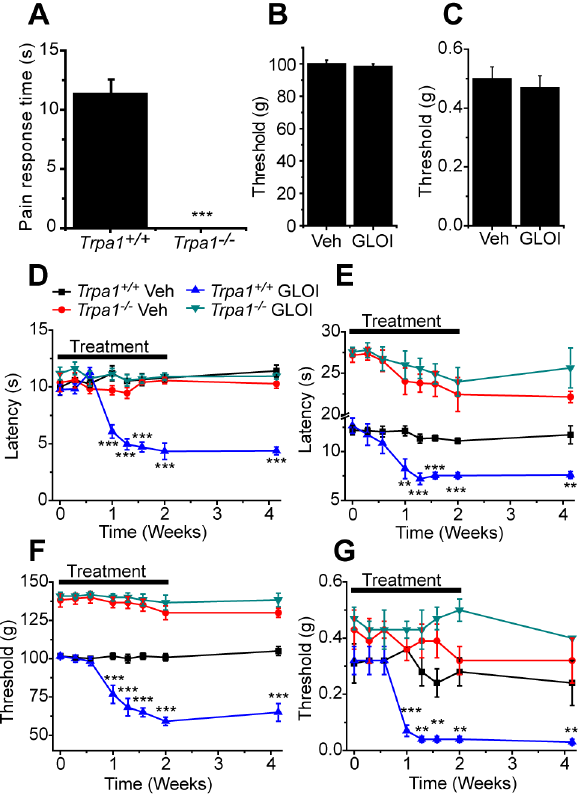
Figure 5. Methylglyoxal produce persistent sensory neuropa- thy. (A) Intraplantar injections of MG (250 nmoles in 25 m l) evokes nociceptive behaviors in wildtype mice but is without effect in Trpa1 2 / 2 mice (n=6). Injections of the GLO-1 inhibitor Sr-p-Bromobenzylglu- tathione cyclopentyl diester (GLOI, 50 mg/kg, 1h before test) did not acutely affect the withdrawal threshold in the paw pressure (B) or von Frey (C) tests compared to mice treated with vehicle (n=6). (D-G) Effect of GLOI or vehicle injections administered every 2 days during a 2 week treatment period on the paw withdrawal latency from a 50 u C hotplate (D), 10 u C coldplate (E), the paw withdrawal threshold in the paw pressure test (F) and in response to stimulation with von Frey filaments (G). The data points are mean 6 SEM from n=6 mice, except for the last time point (15 days after the final injection) where n=3. Data were analyzed by t-test (panel A) or ANOVA followed by Tukey’s HSD test (**P , 0.01, ***P , 0.001 compared to vehicle treated group).